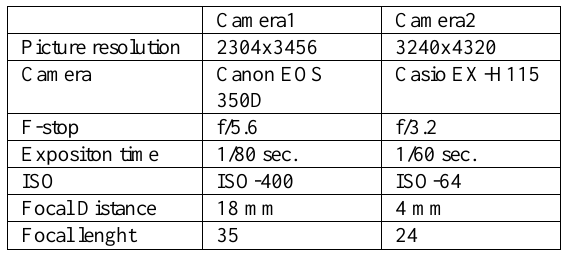
Figure 4. Portal of La Speranza, Cagliari. Result of processing of photo sets obtained with two different cameras: a) model1, Canon EOS 350D; b) model2, Casio